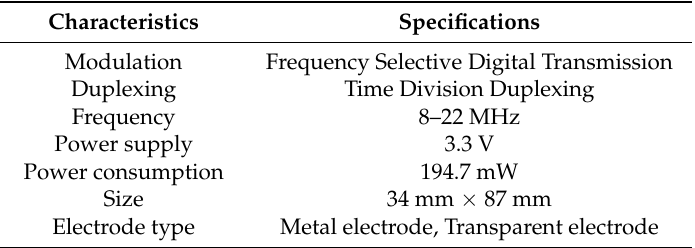
Table 1. Specifications of the human body communication (HBC) module.